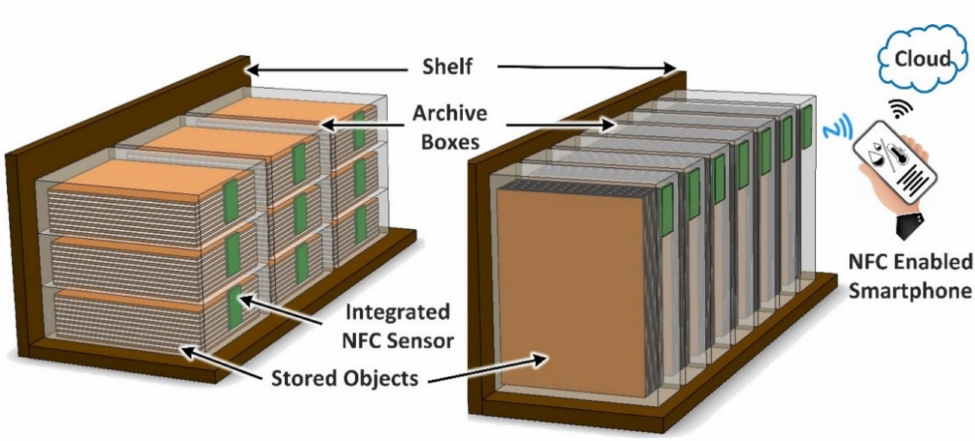
Figure 1. Illustration of the proposed solution for artifact storage monitoring using a novel battery- less temperature and humidity NFC sensor powered using a standard